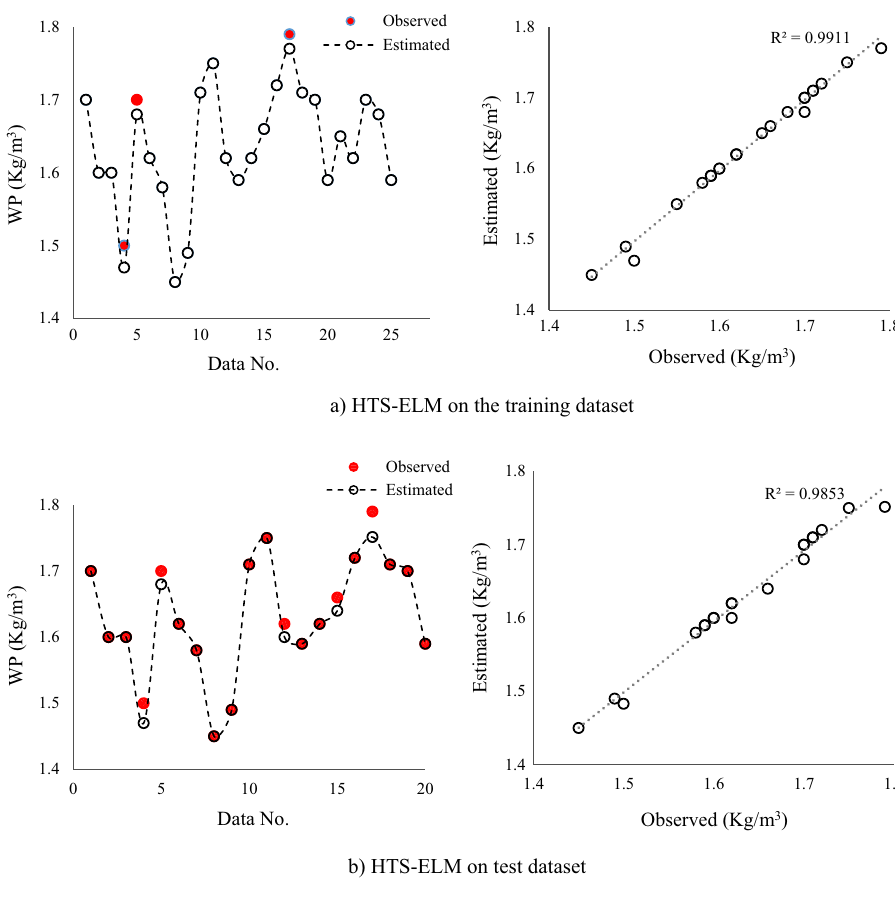
Fig. 8 a , b Comparison of esti- mated and observed WP